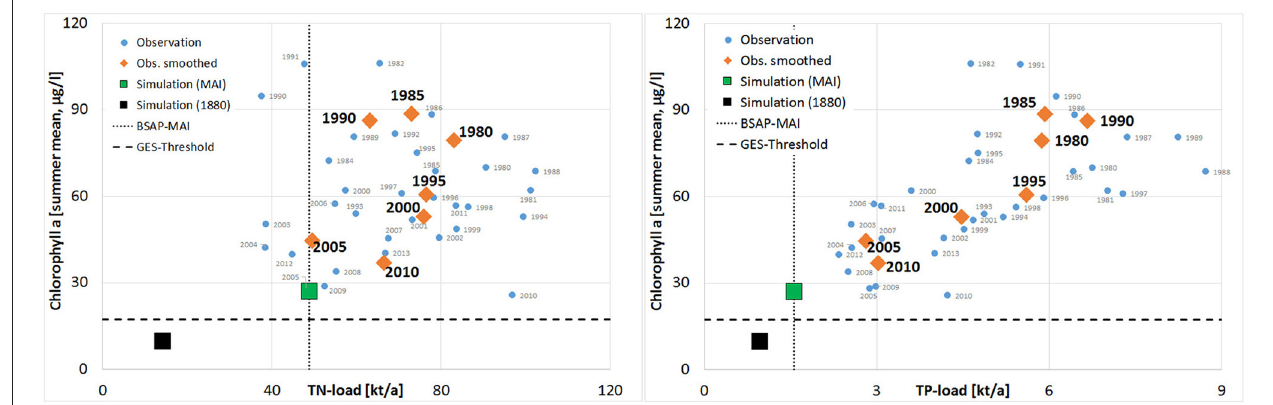
FIGURE 5 | Observed summer Chl-a at station C (Large Lagoon) as function of the annual TN and TP inputs to the entire lagoon (blue cycles—annual values; orange diamonds—averaged over 5 years). Additionally are shown: (i) MAI of HELCOM BSAP and proposed GES-thresholds (black lines); (ii) pre-industrial simulated water quality and nutrient loads (black square); (iii) simulated water quality using MAI (green, including a moderate climate change).